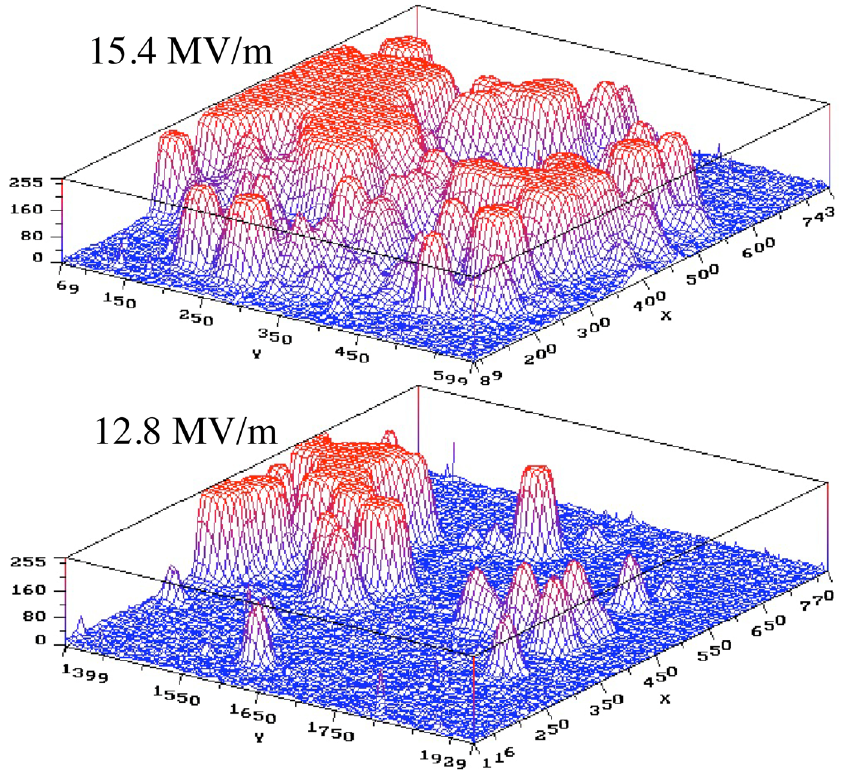
FIG. 6. (Color) Digitized images of the field emitted currents at different gradients. The digitized area is 7 by 7